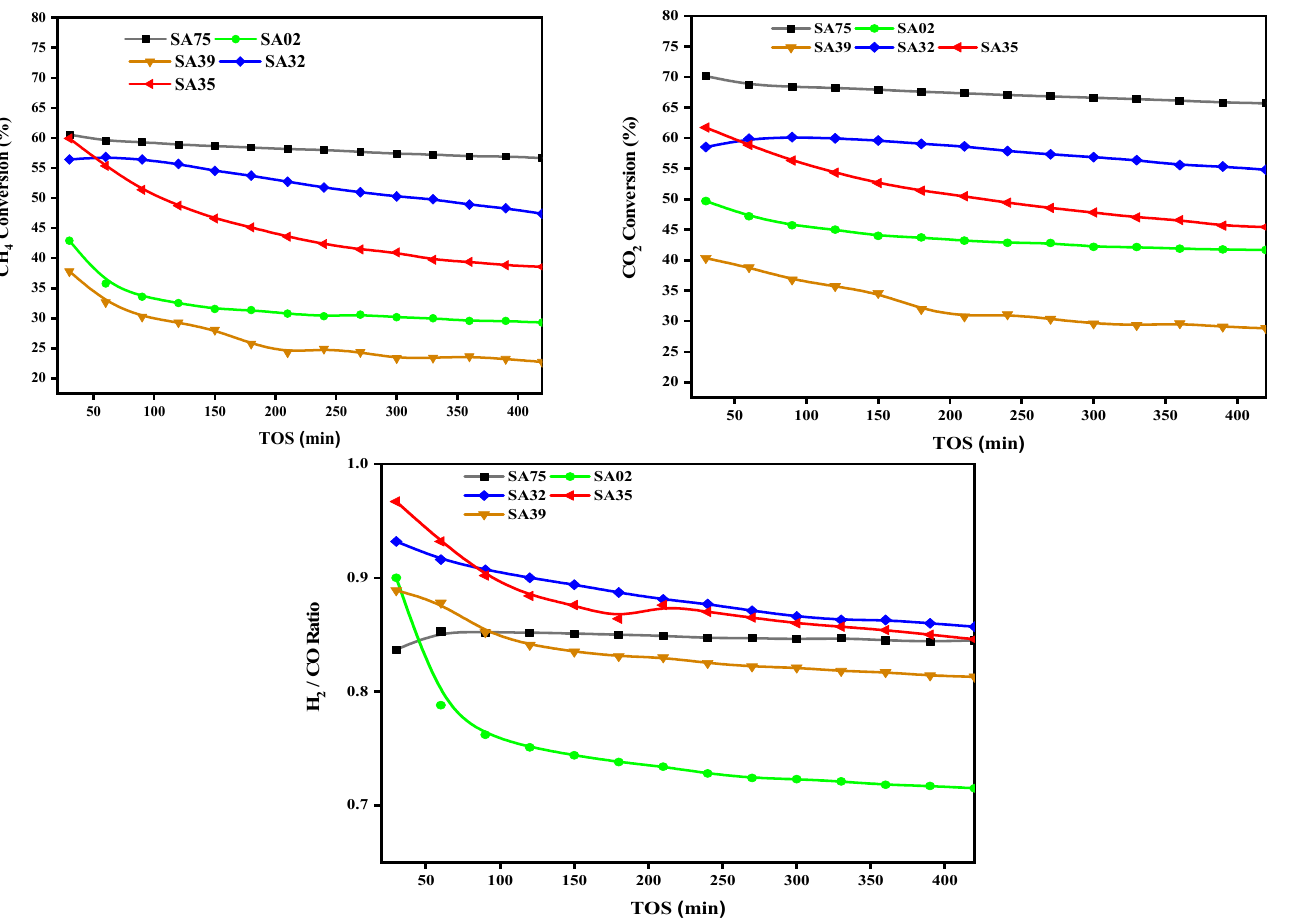
Figure 7. Conversions of CH 4 , CO 2 , and H 2 /CO ratio at 700 °C, ambient pressure, and GHSV = 48 l/(h·g cat ) of the Ni-supported catalysts. Table 1. Comparison of the results of this work with those reported earlier for alumina.